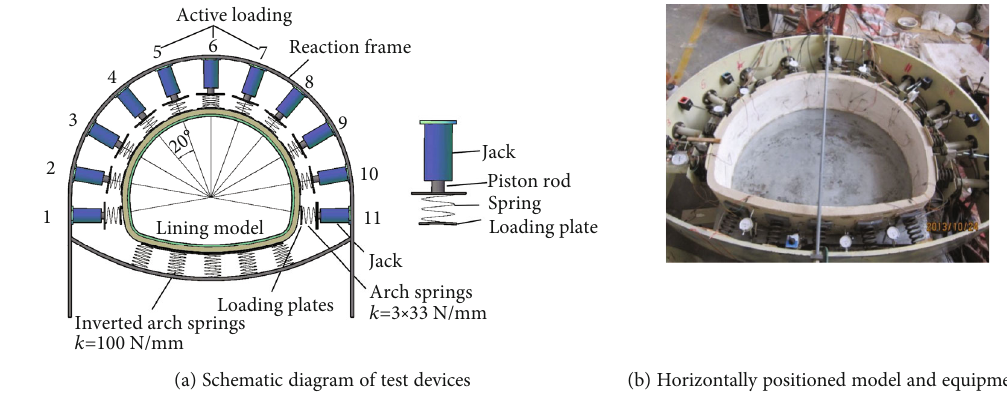
Figure 1: Test Table 1: Similitude ratios of physical quantities.